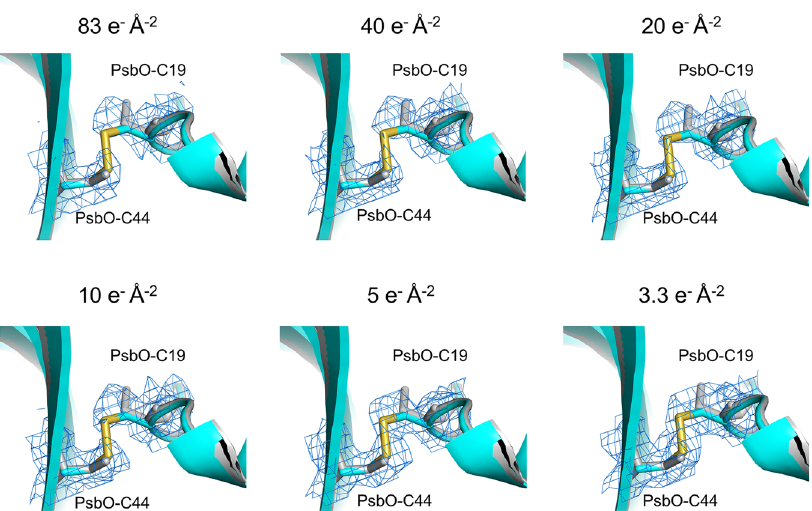
Fig. 5 Changes of the cryo-EM map in the region of the disul fi de bond in PsaO with changes of the electron beam dose. The cryo-EM maps for each electron dose are displayed as a blue mesh at 4 σ and the corresponding models for low-dose (colored) and high-dose (gray) are shown as